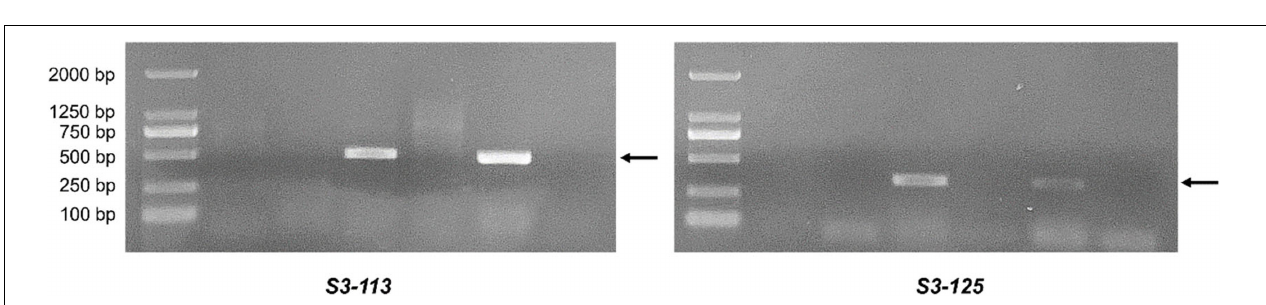
FIGURE 5 | Sequence characterized amplified region (SCAR) markers analysis of DH109 and DM131. SCAR marker S3-113 and S3-125 designed base on sequences of P. huashanica 3Ns chromosome only amplified bands in DH109 and P. huashanica but not in DM131 and L. mollis. Lane M, DL2000 marker; lane 1, common wheat 7182; lane 2, Trs-372; lane 3, DH109; lane 4, DM131; lane 5, P. huashanica ; lane 6, L. mollis . Arrows indicate the P. huashanica 3Ns chromosome–specific